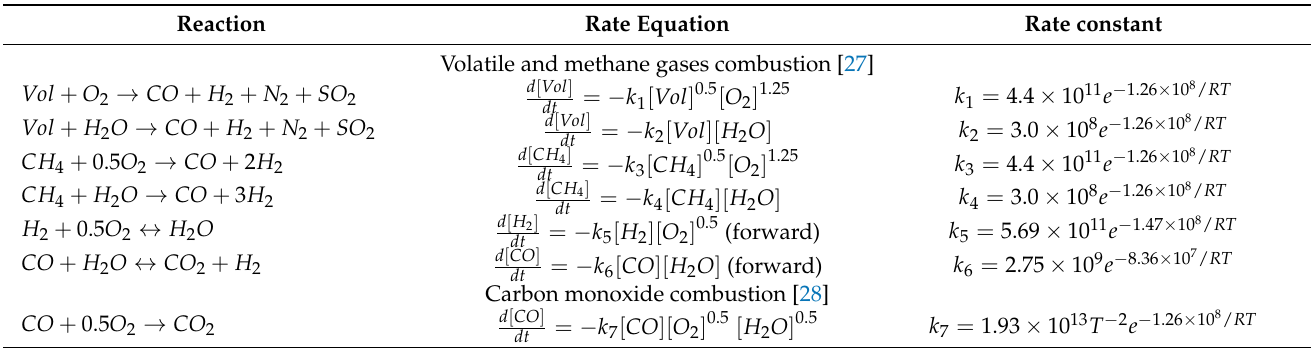
Table 1. Homogeneous reactions with the kinetic rate.